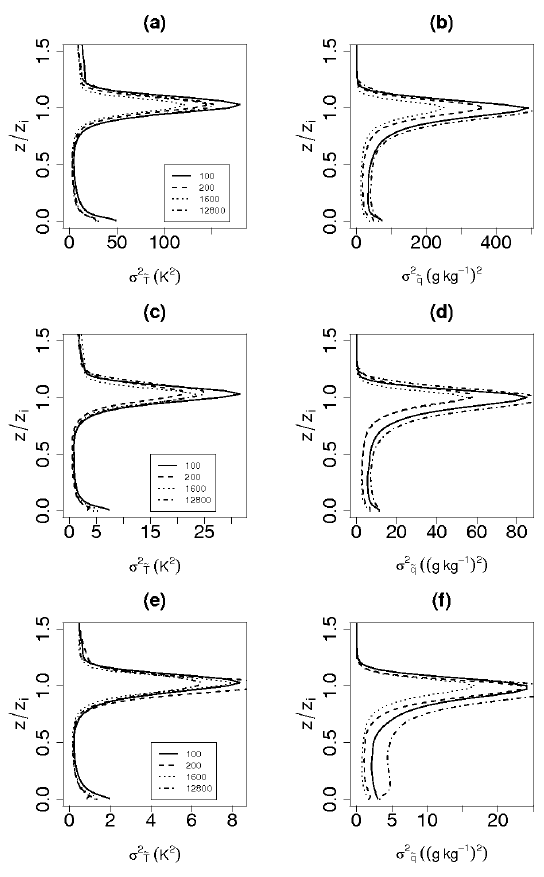
Fig. 14. Spatial variances of scalars (a) temperature [K] and (b) specific humidity [(g kg − 1 ) 2 ] for (top) low, (middle) intermediate and (bottom) high wind speeds